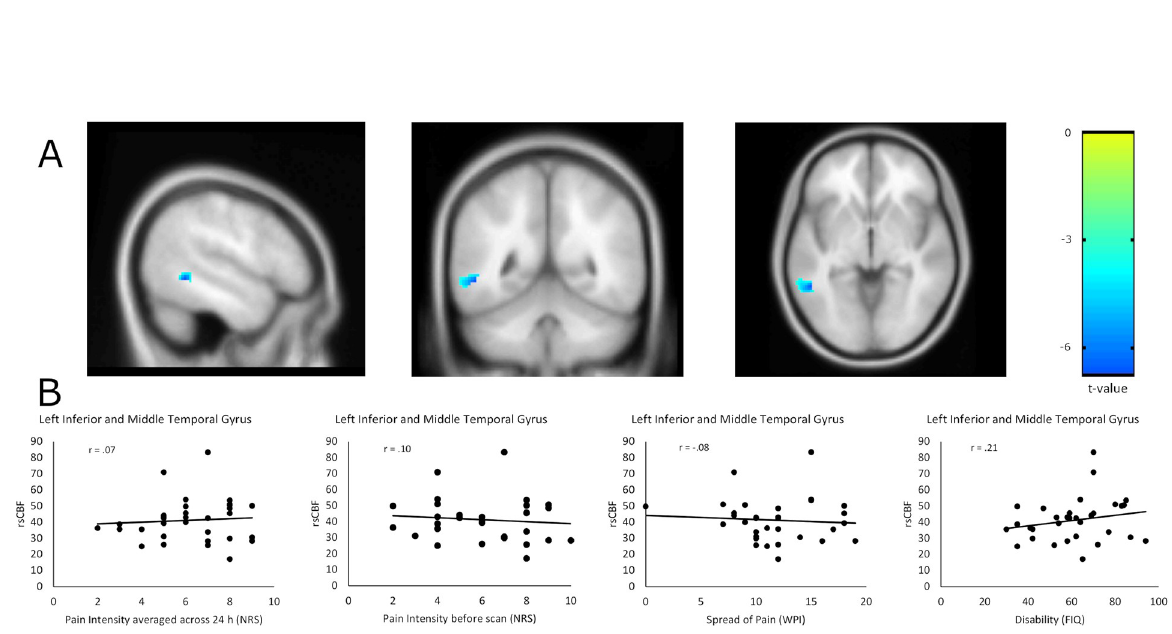
Fig 2. Adjusted difference in resting-state cerebral blood flow (rsCBF) between cases (N = 32) and controls (N = 32) in the left Inferior Middle Temporal Gyrus (x = -50; y = -50; z = -4) controlling for mean global rsCBF, depression and anxiety at cluster-level of 10 voxels (A) and correlation of pain characteristics with rsCBF of this region within patients (N = 32) (B). Displayed are cluster-sizes of > 10 voxels with colors indicating t-values. NRS: Numerical Rating Scale from 0 (no pain) to 10 (maximum pain). WPI: Widespread pain index from 0 (no body region with pain) to 19 (all body regions with pain). FIQ: Fibromyalgia Impact Questionnaire from 0 (no disability) to 100 (most severe disability). r: correlation coefficients.